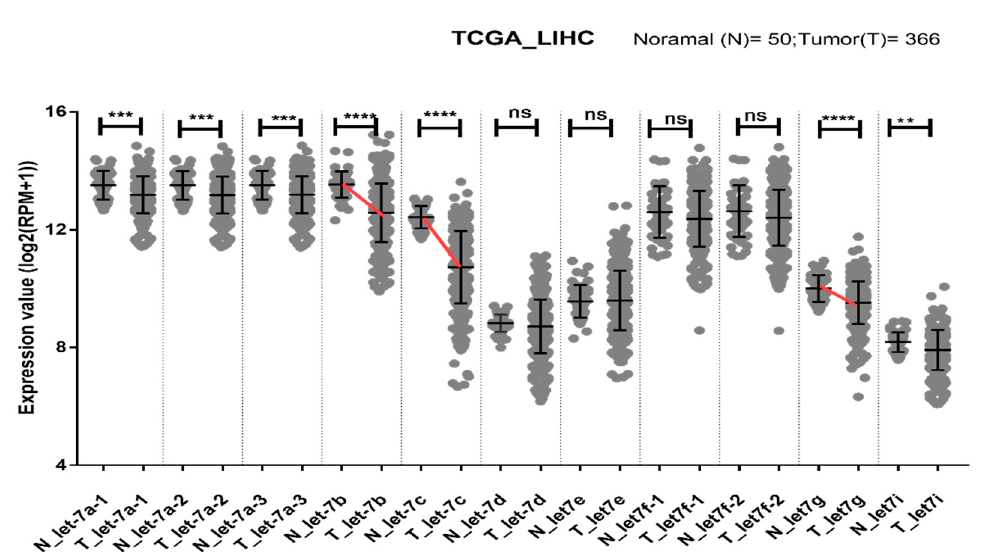
Figure 3. Dot plot showing the relationship between the expression of let-7 family members in normal ( n = 50) and tumor ( n = 366) tissues from liver cancer patients in the TCGA dataset. Log 2 (RPM + 1) transformed values for let-7 family members are shown as the mean ± SD. Prominent declines in let-7b / c / g are indicated by red lines. Statistical significance was assessed using the Mann–Whitney test. The p values are represented as follows: ** = p < 0.01, *** = p < 0.001, **** = p < 0.0001.